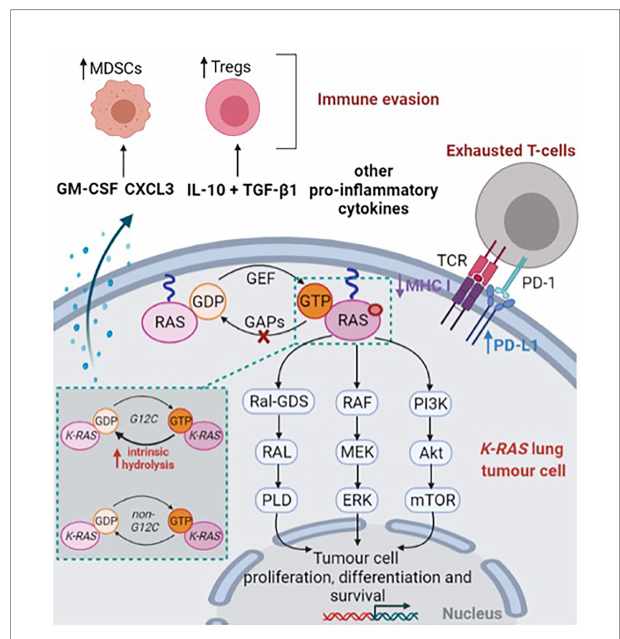
FIGURE 1 | KRAS -mutant lung tumor cell. This fi gure was created with